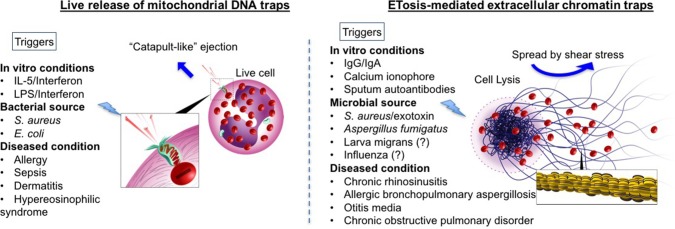
Comprehensive schematic of two theories of eosinophil extracellular trap formations: Comparison between mitochondrial DNA (mtDNA) traps (Left) and ETosis mediated extracellular traps (Right) are given. Blue arrows indicate how traps are spread extracellularly. In mtDNA theory, live eosinophil rapidly ejects mtDNA, which are loaded with specific eosinophil granule protein. MtDNAs are launched and spread into the extracellular space with a speed of at least 10–20 micrometer s−1, by unknown mechanism [suggested to be the stored elastic energy like plants catapulting pollen in the air (18)]. In contrast, ETosis-generated extracellular traps are mediated through active cell death program. Nuclear and plasma member disintegration during an event of cytolysis, allow for the release of chromatin-based web-like extracellular traps (as depicted in the enlarged image in square). Extracellular traps spread by a passive process. Shear stress (for example, cough, respiration, fluid flow including Brownian motion) enable to distribute free granules (red) and extracellular traps. Other triggers such as immunoglobulins and microbes have also been shown to release histone-coated EETs with evidence of cell death (19, 36, 37). The different triggers known (or reported in literature) to release EETs via both mechanisms have been listed (please note that this is not an exclusive list). For those with inconclusive evidence (or with evidence only from mouse models) have been indicated with a question mark.